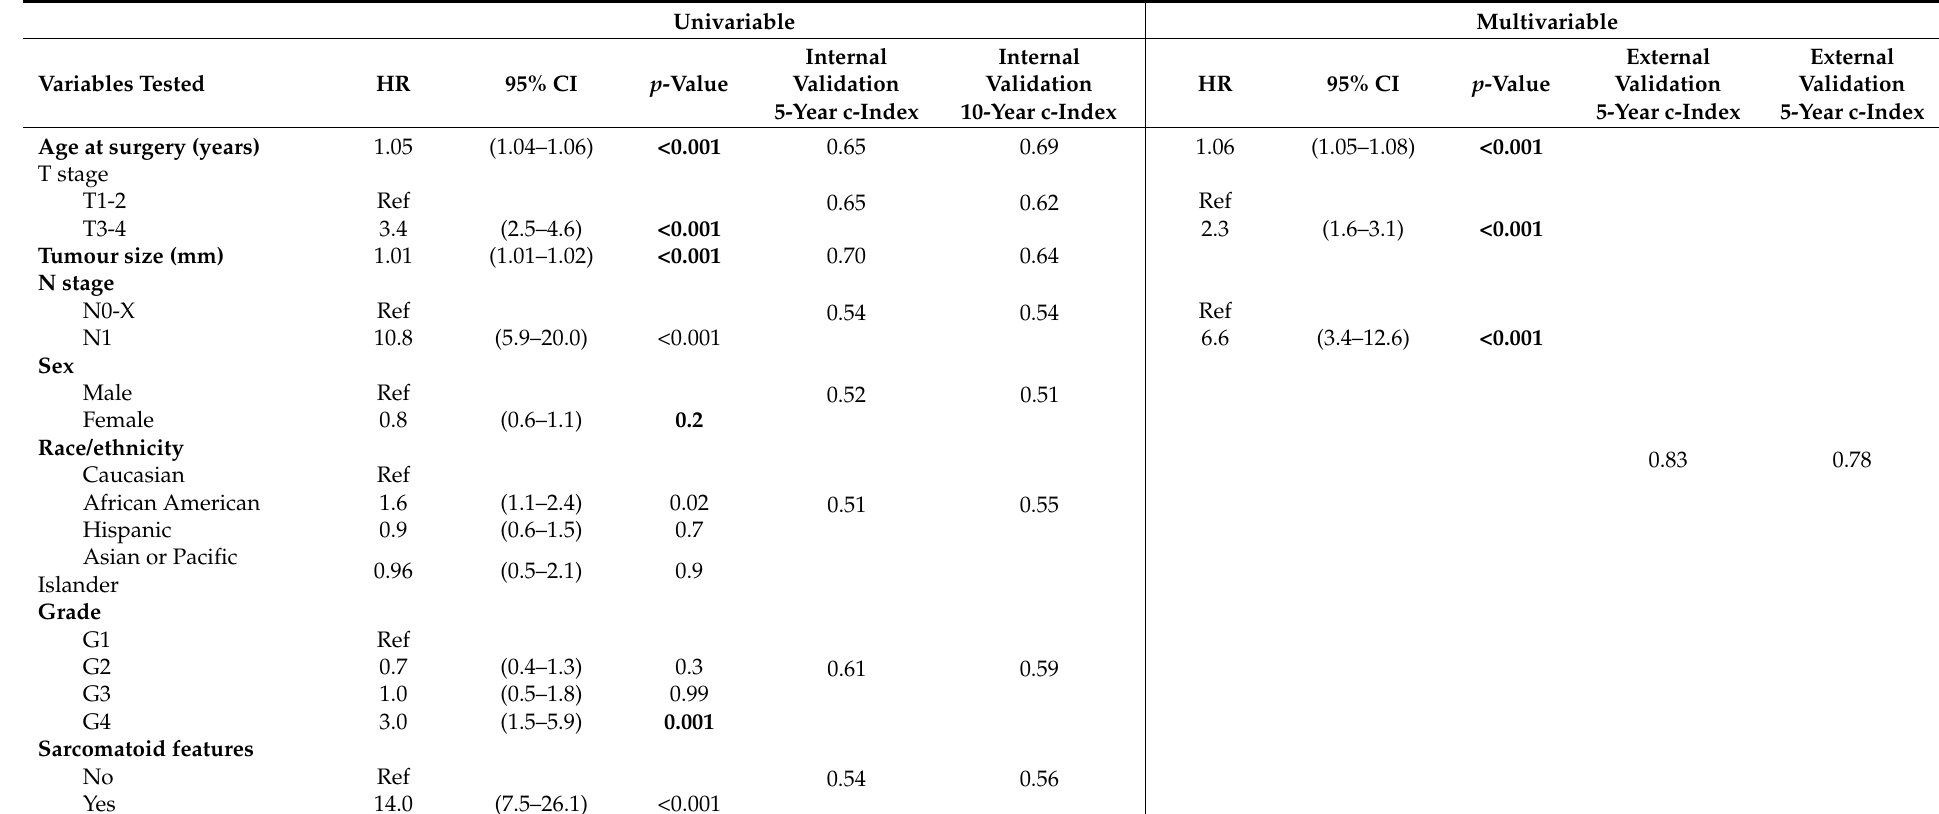
Table 3. Univariable and multivariable Cox regression models predicting cancer-specific mortality. For each model, c-indexes addressing the concordance between predicted and observed survival rates at five and ten years are provided. All patients were diagnosed with unilateral surgically treated non-metastatic chromophobe renal cell carcinoma between 2000 and 2019 in the Surveillance, Epidemiology, and End Results database.